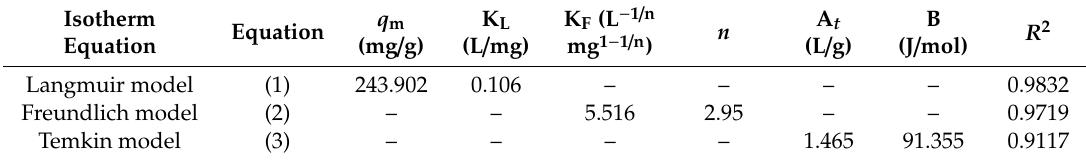
Figure 4. ( a ) Adsorption isotherm of Evans Blue to Fe-DC at pH 7. Isotherm plots and fits of the ( b ) Langmuir, ( c ) Freundlich, and ( d ) Temkin models. Equations used for fitting the data are listed in Section 2.4. Table 1. Obtained isotherm model parameters for the adsorption of Evans Blue.